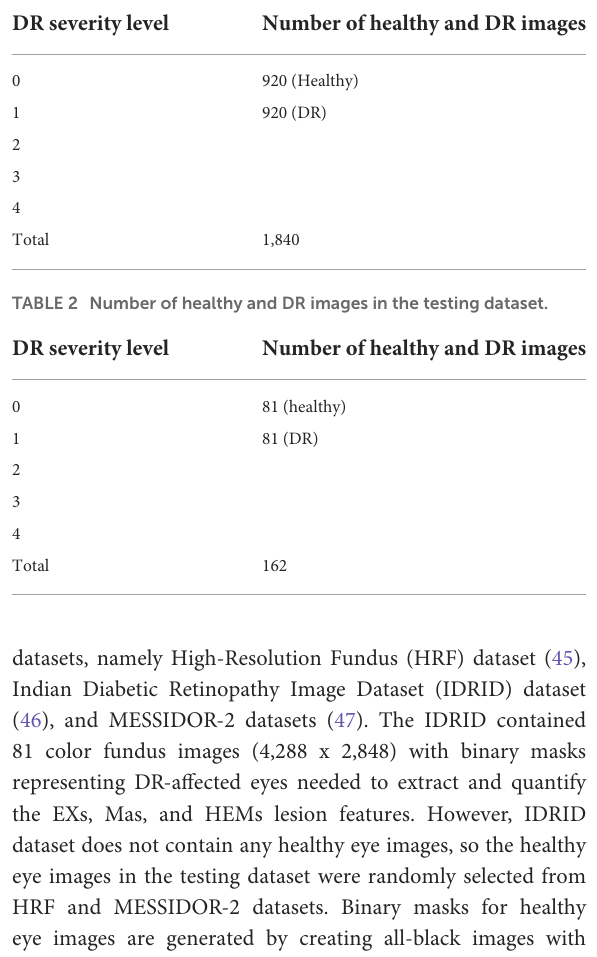
TABLE 1 Number of healthy and DR images in the training dataset.